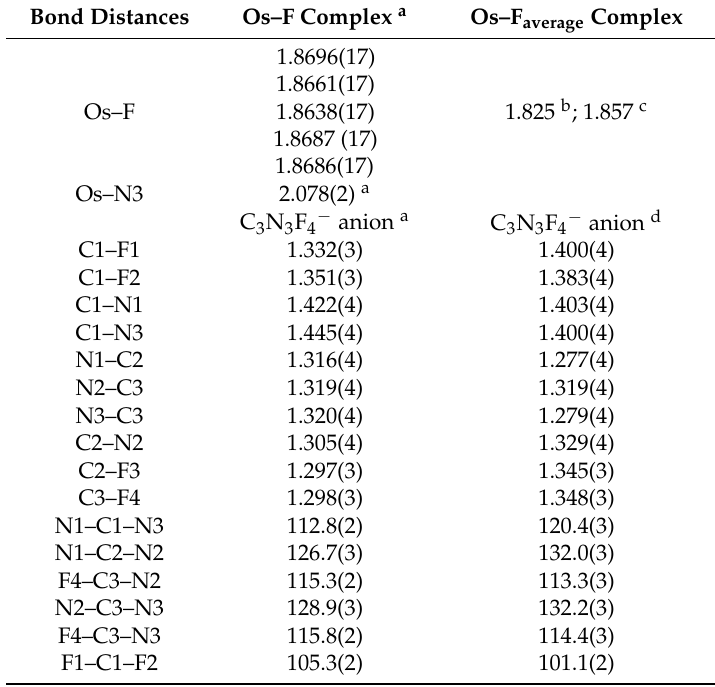
Figure 3. Charge delocalization in C 3 N 3 F 4 − anion. Table 2. Selected bond lengths (Å), bond and angles (°) in 1.